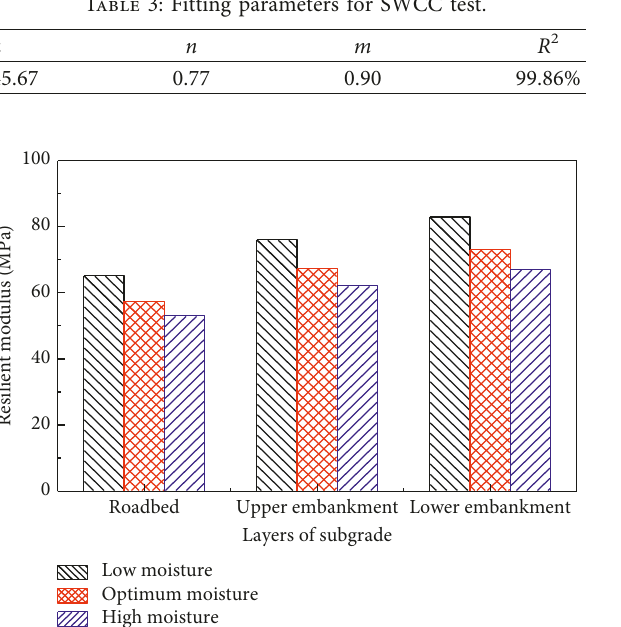
Figure 7: Effect of moisture content on the Mr of subgrade soils.